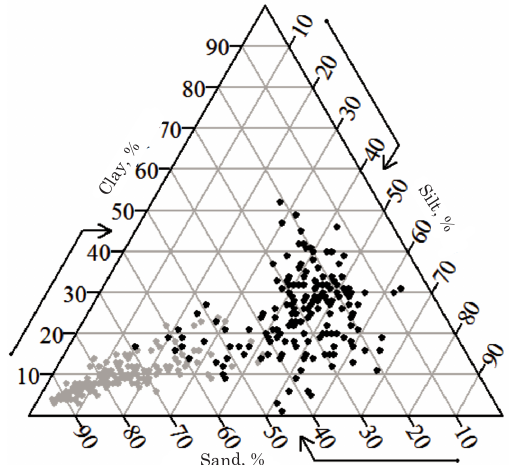
Figure 2. The particle-size distribution of the soils according to its parent material (black - igneous rocks, gray - sedimentary rocks).